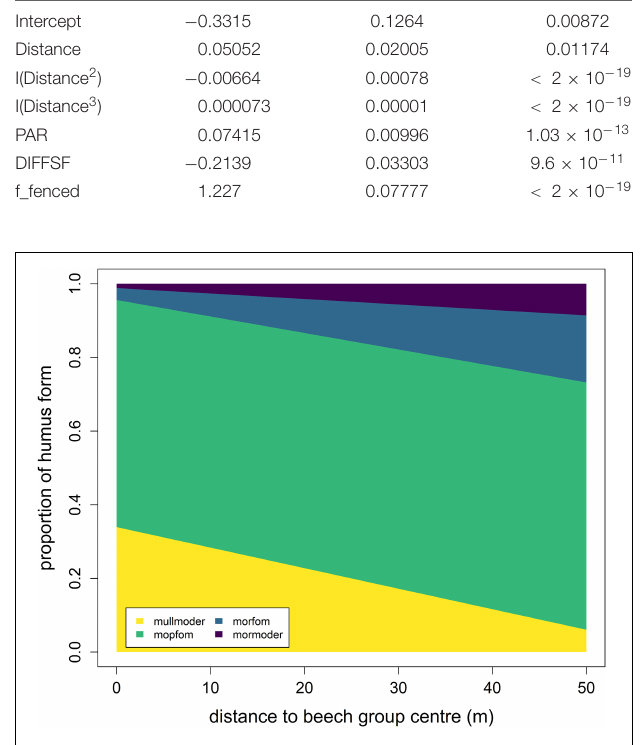
FIGURE 4 | Results of the ordered categorical model for modelling humus form as a function of distance from the centre of the beech group.